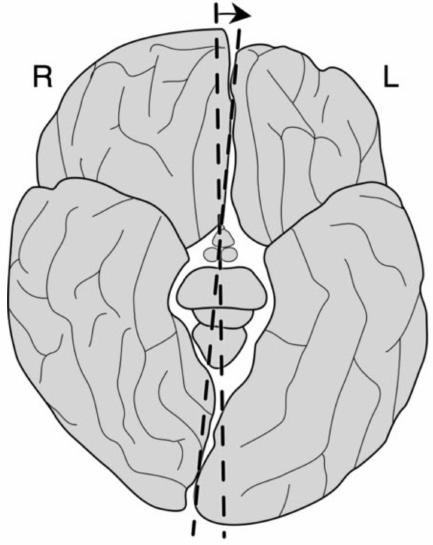
Figure 7. Illustration of the formation of asymmetry of the cerebral hemispheres. Since it was first described by Paul Yakovlev, it is also called Yakovlev’s twisting (torque) of the brain in a counter- clockwise direction (Yakovlev cerebral anticlockwise torque). In the diagram, the twist is not shown from above, but from below (so in this view it is clockwise). Twisting also leads to asymmetry of the protrusion of the inner surface of the skull bones (petalia) as the bones adapt to the shape of the brain (and not vice versa). The scheme is from